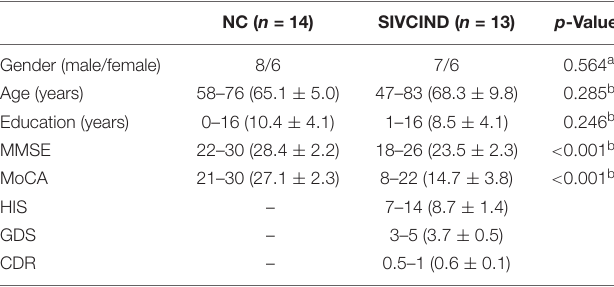
TABLE 1 | Demographics and clinical characteristics of the